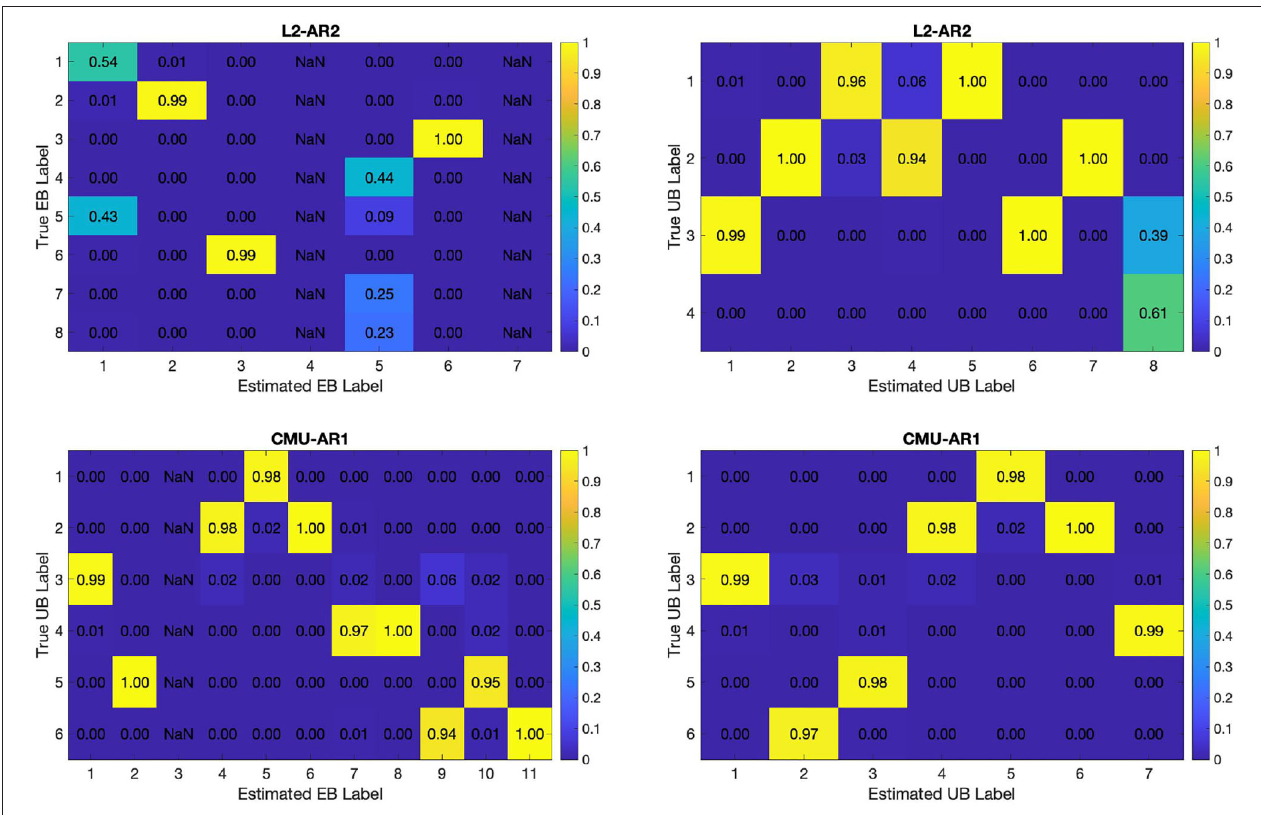
FIGURE 4 | Confusion matrices for an example of segmentation results for both EB and UB steps. Numbers normalized per column. (Top) Toy data. (Bottom) CMU motion